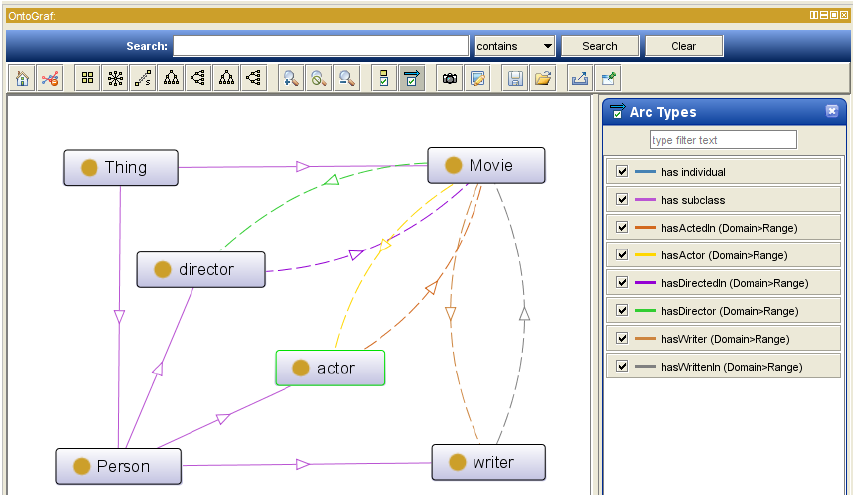
Figure 2. Structure diagram of the ontology library.